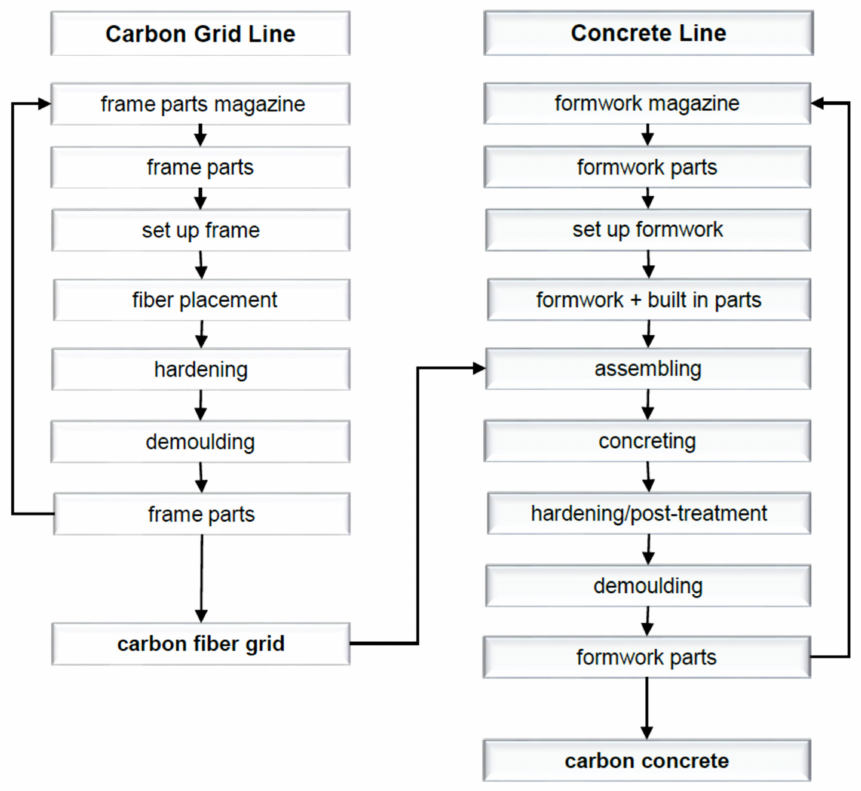
Figure 10. Scheme of the automated pilot line for concrete-based